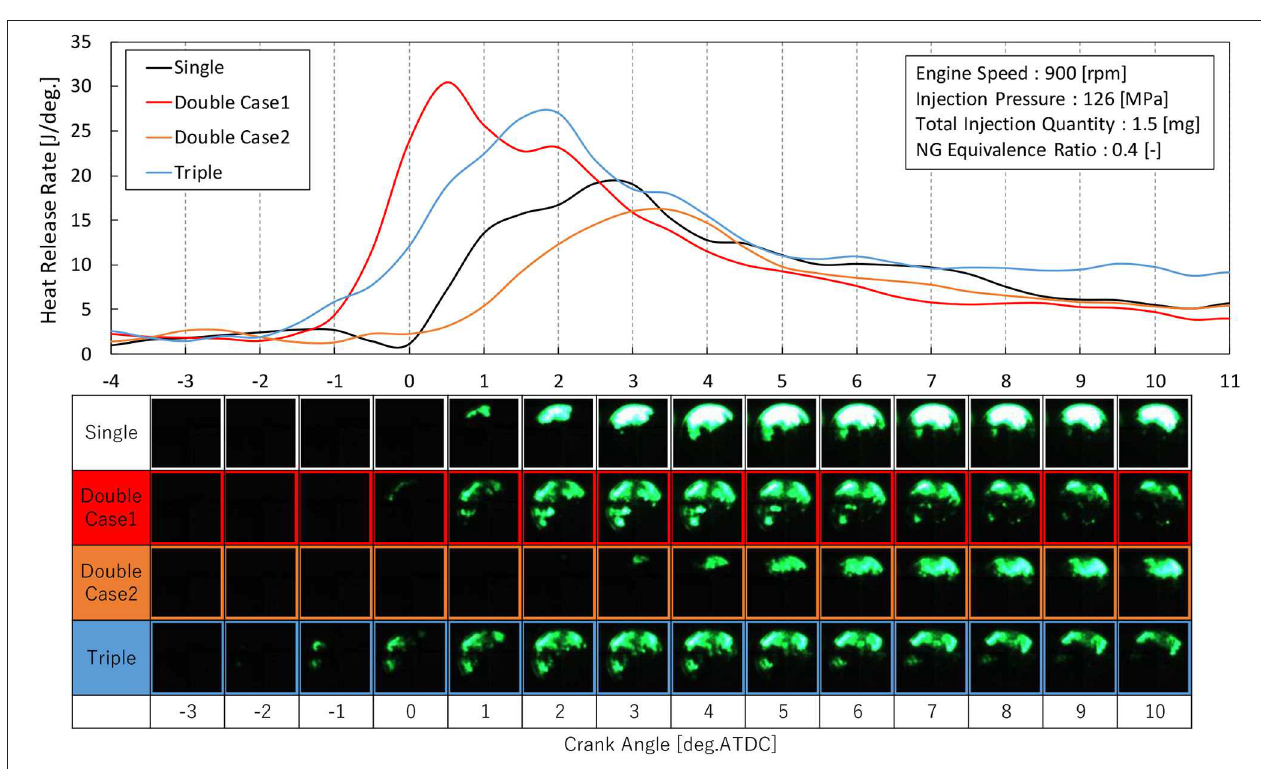
FIGURE 2 | Heat release rate and pictures of the combustion chamber.